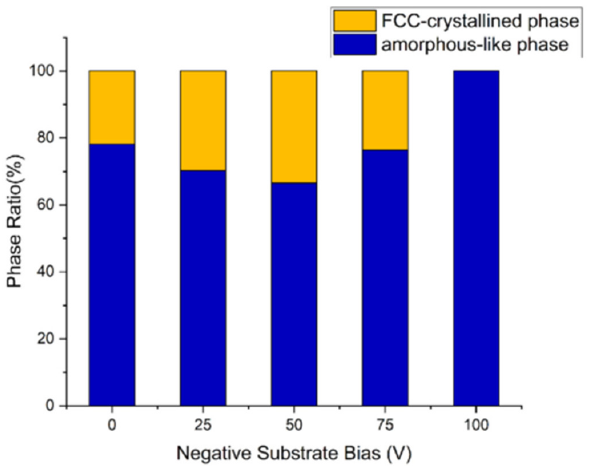
Figure 5. The correlated phase ratio of (AlCrSiNbZr)N film with different substrate biases. Re- printed with permission from [54]. 2020,